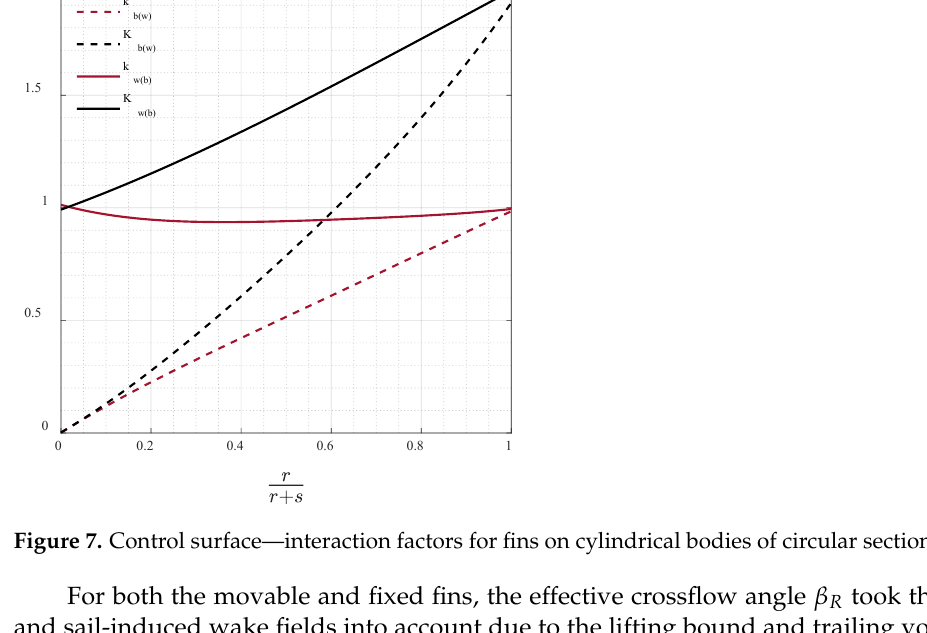
and torque curves and the 𝐾𝐾 𝑠𝑠 𝐾𝐾 𝑞𝑞 2 4 was included to encompass the unbalancing of tangential forces along the blade revolu- 𝐾𝐾 𝑆𝑆 = 𝑆𝑆 / 𝜌𝜌𝑛𝑛 𝐷𝐷